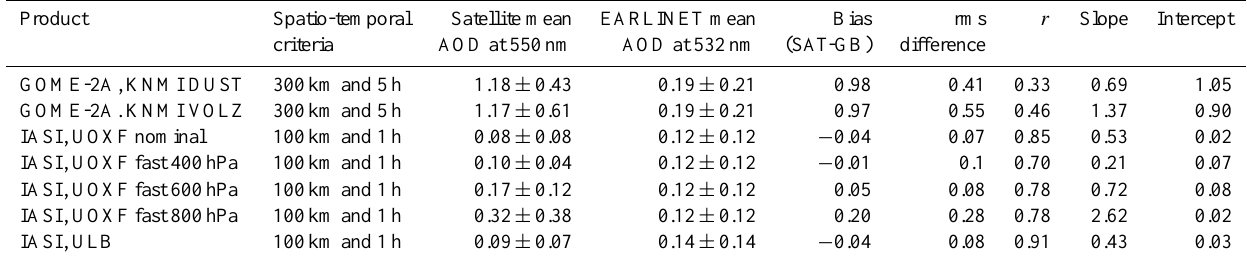
Table 4. Statistical mean values and associated standard deviation for the EARLINET and the satellite ash optical depth estimates presented for collocated